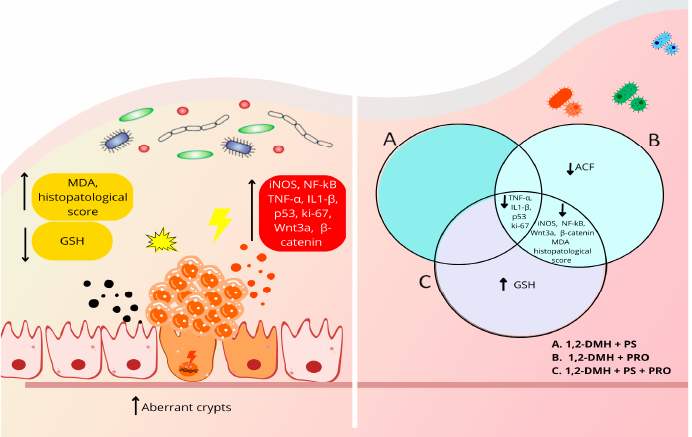
Figure 6. The outcome of PRO and/or PS supplementation in an experimental model of CRC devel- opment with 1,2-DMH. 1,2-DMH increased histopathological scores, OS (elevated MDA and reduced GSH), and selected inflammatory and tumorigenesis markers (Ki67, β -catenin, Wnt3a, p53, NF-kB, iNOS, IL1- β , and TNF- α ). 1,2-DMH + PRO and 1,2-DMH + PS + PRO reduced histopathological scores, and selected inflammatory and tumorigenesis markers (Ki67, β -catenin, Wnt3a, p53, NF-kB, iNOS, IL1- β , and TNF- α ) and improved OS (MDA). 1,2-DMH + PS + PRO also increased intestinal GSH levels. 1,2-DMH + PS reduced p53, Ki67, IL1- β and TNF- α tissue expression, but without improving OS and histopathological scores. ↑ , increased; ↓ , decreased. Progression from this precursor lesion to CRC is a multistep process, accompanied by alterations in several suppressor genes that result in abnormalities of cell regulation,